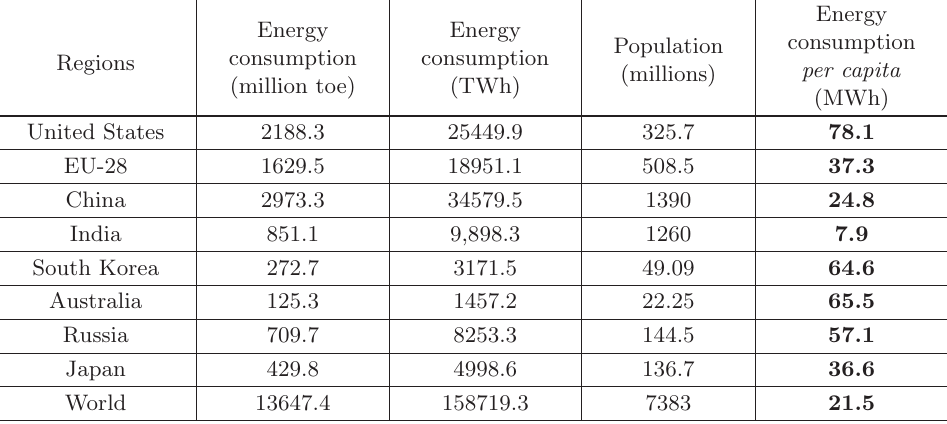
Table I. – Comparison of the annual energy consumption per capita between different regions of the world [6-10] . 1 toe = 11 . 63 megawatt-hour (MWh). Energy Energy Population Regions